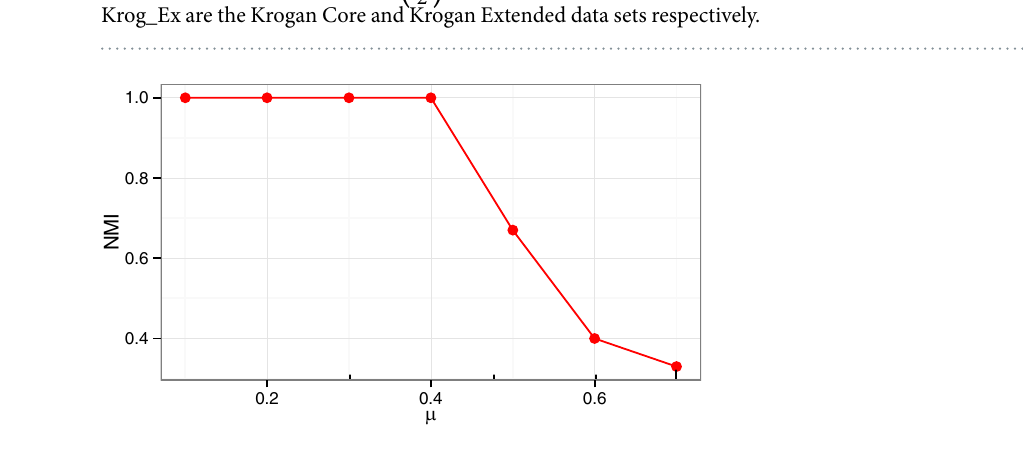
Figure 2. The figure shows the NMI values obtained by running the proposed method on GN network instances with different values of μ